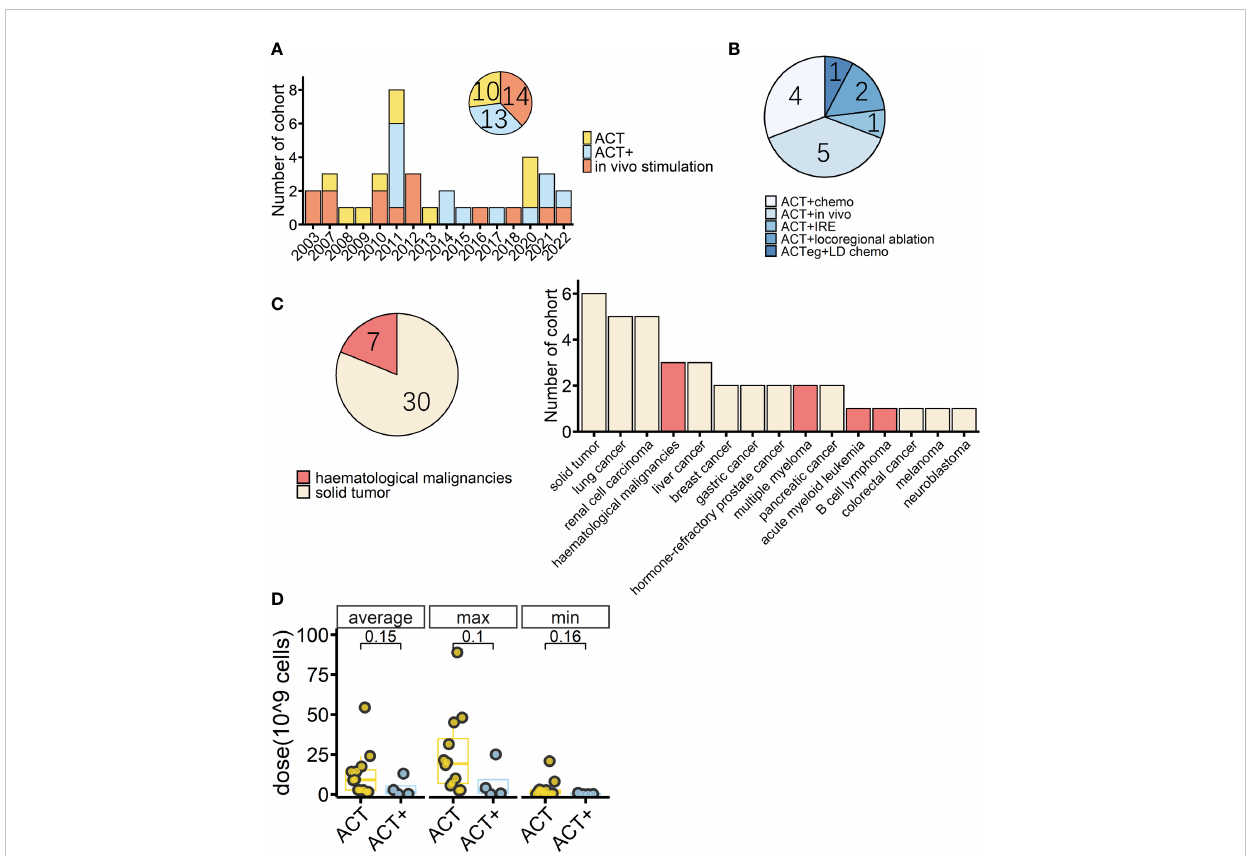
FIGURE 1 Overview of cohorts from completed gd T-cell immunotherapy trials. (A) Timeline of completed gd T-cell immunotherapy trials in clinics by cohort; colors indicate treatment type ( n = 37). (B) Detailed treatment methods applied in the cohorts treated with adoptive cell transfer (ACT) combined with other treatments except for IL-2 treatment (ACT+) ( n = 13). Chemo: conventional therapies, mostly chemotherapy . In vivo : in vivo stimulation of V g 9V d 2 T cells using zoledronate. IRE: irreversible electroporation. ACTeg: engineered T cells. LD chemo: lymphodepletion chemotherapy. (C) Tumor types (pie chart) and detailed diseases (bar chart) of gd T-cell immunotherapy cohorts ( n = 37); colors indicate treated tumor types. (D) Average, maximum, and minimum gd T-cell total infusion doses of cohorts with dosage information (ACT, n = 12, ACT+, n = 4). The lower and upper hinges of the boxplot show the 25th and 75th percentile, respectively. The medians are indicated inside the box, and p -values (Wilcoxon rank-sum test) are also